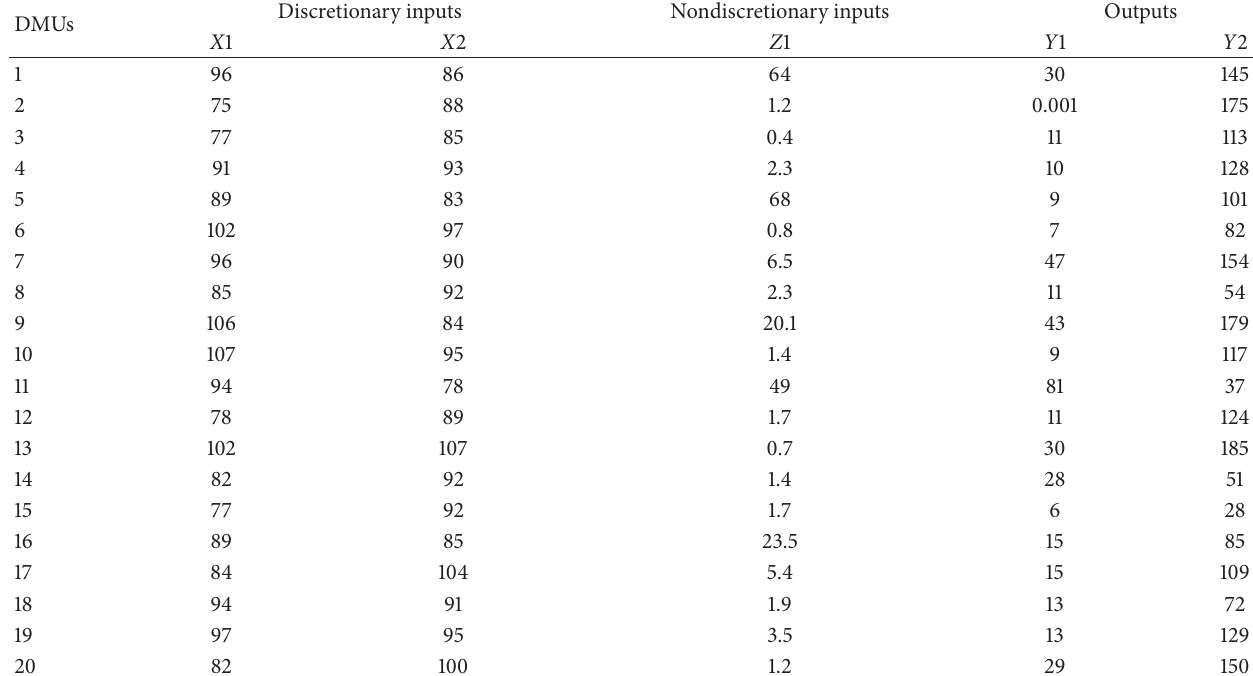
Table 3: The data of 20 bank branches.